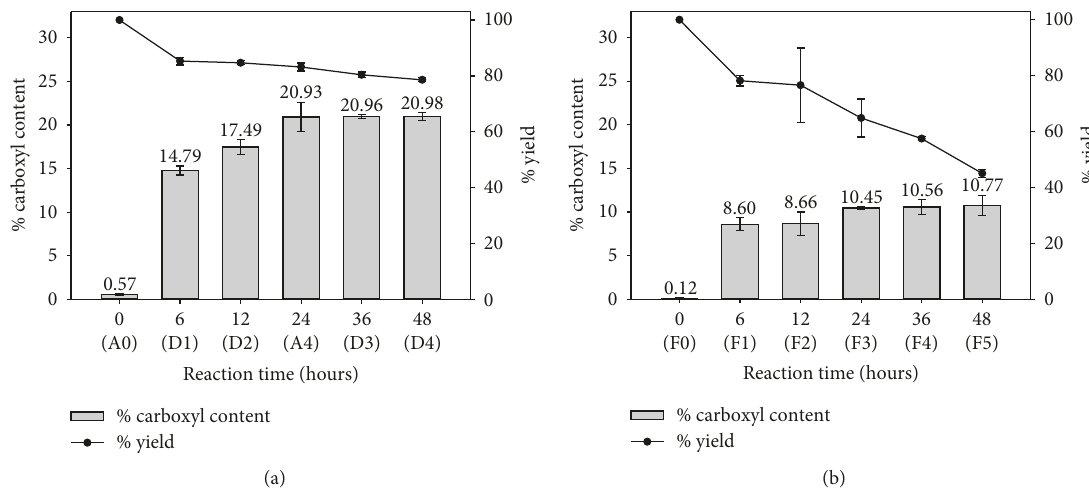
Figure 6: Effect of reaction time on the carboxyl content and % yield of the OC products from (a) DNDC and (b) natural cotton linter. The reaction was performed at 30 ° C by using 1:3 HNO 3 /H 3 PO 4 mixture and 1.4% (w/v) of NaNO 2 .